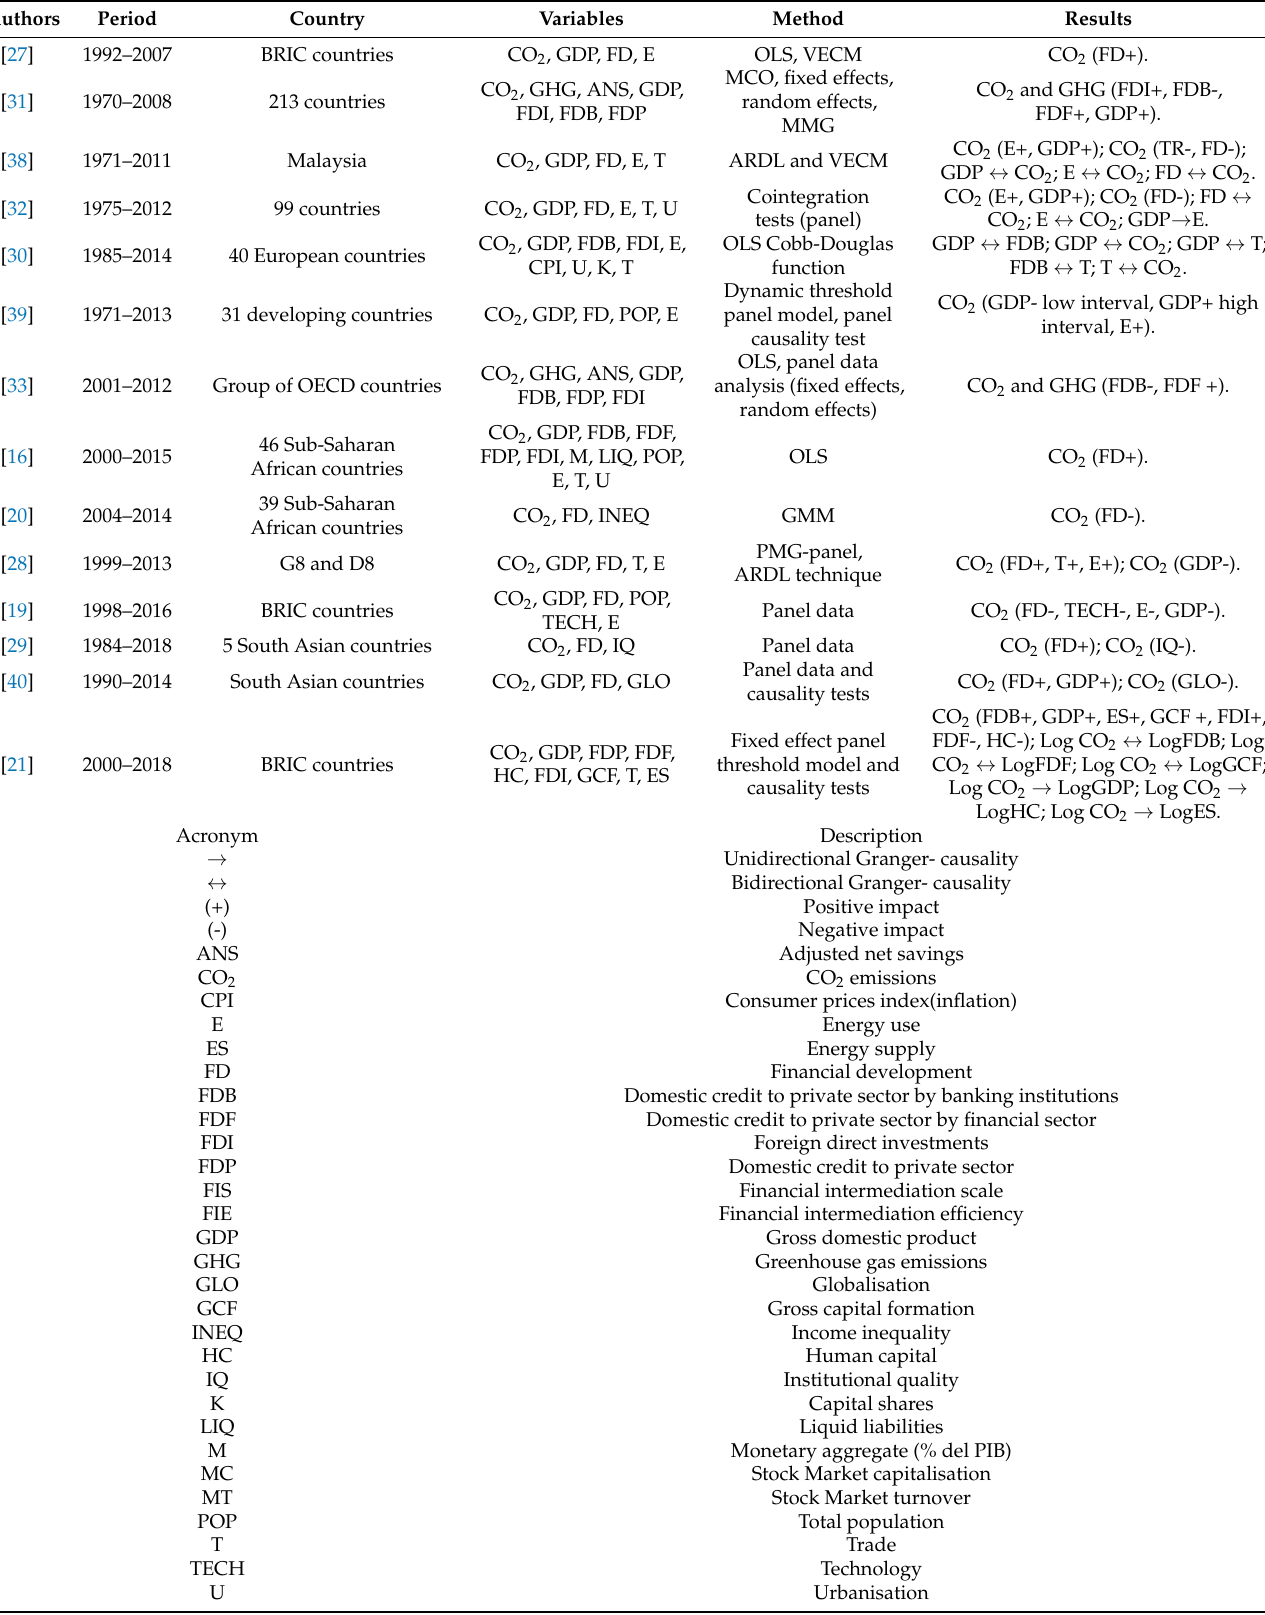
Table 1. Literature review of the role of financial system on environmental